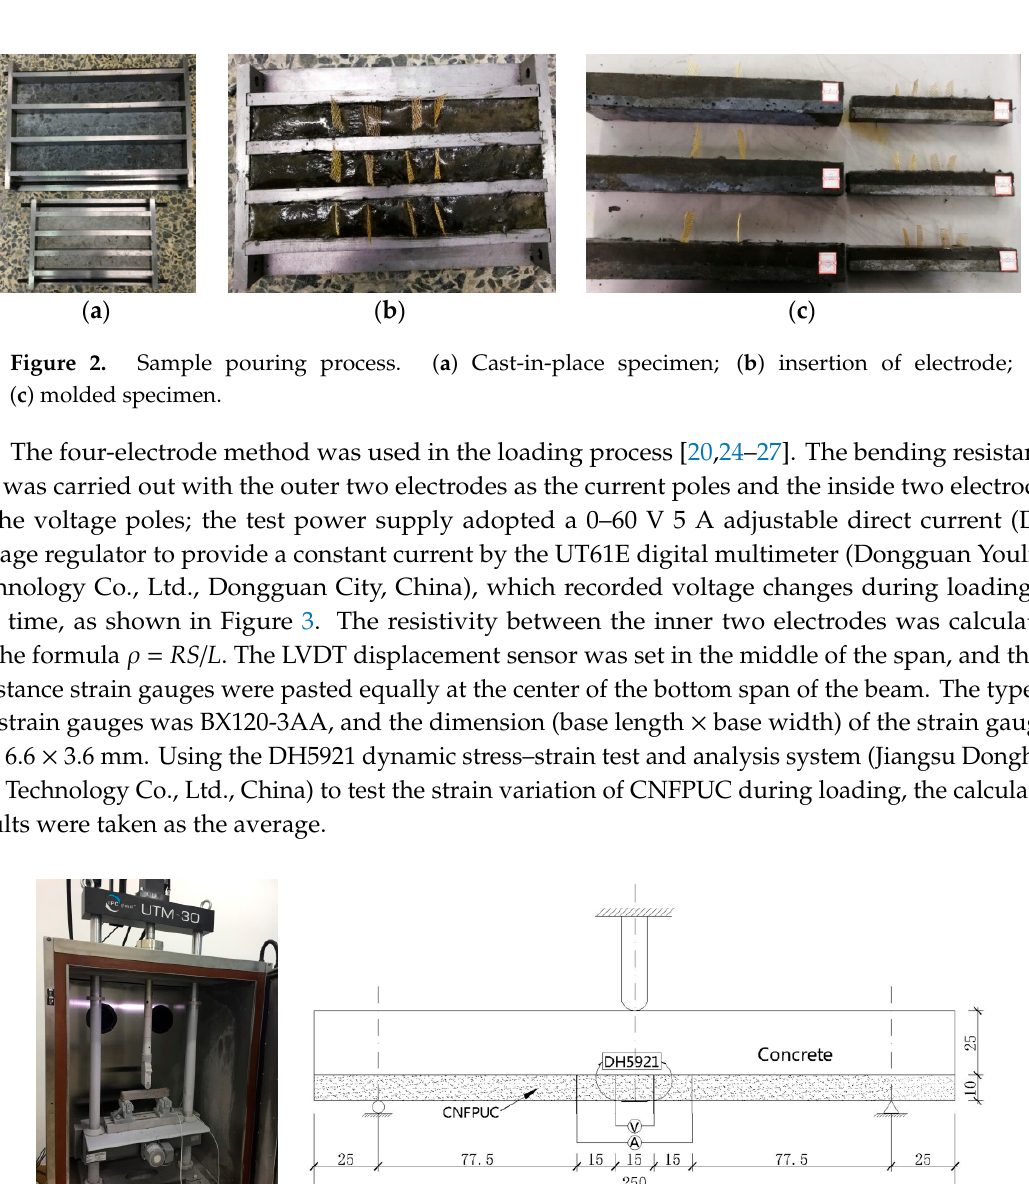
( b ) Figure 1. Vibratory compactness of specimens and their dimensions. ( a ) Specimen vibration compactness; ( b ) drawing of test piece size (mm). Table 6. Mass ratio of carbon nanofiber polyurethane cement (CNFPUC) components (%). CNFPUC Component